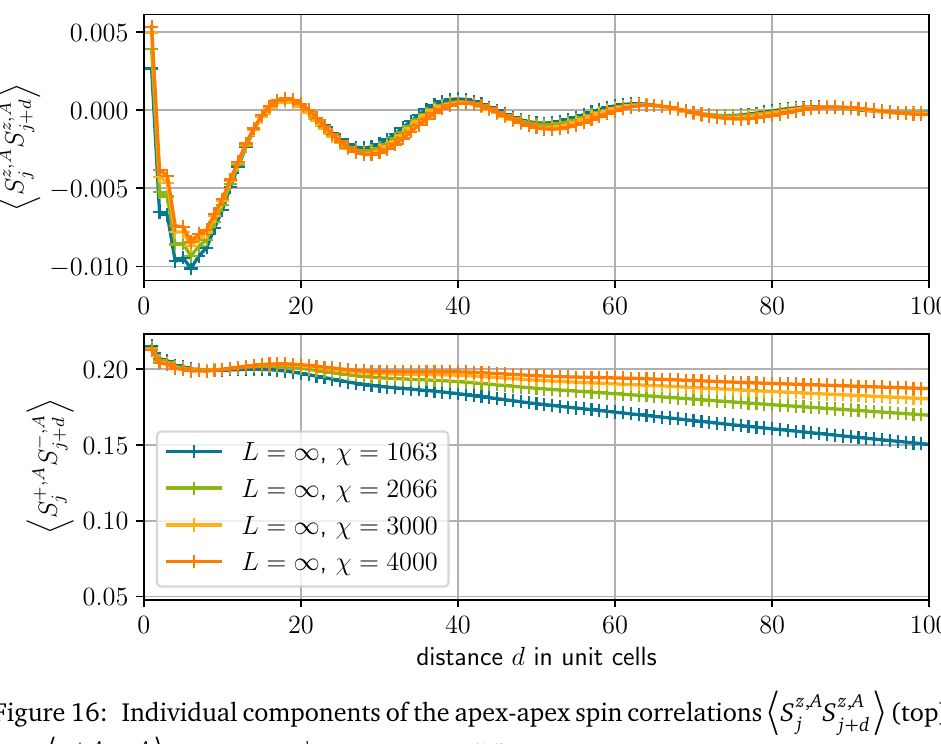
± , α = S x , α ± iS y , α ) computed in the infinite system with j j j